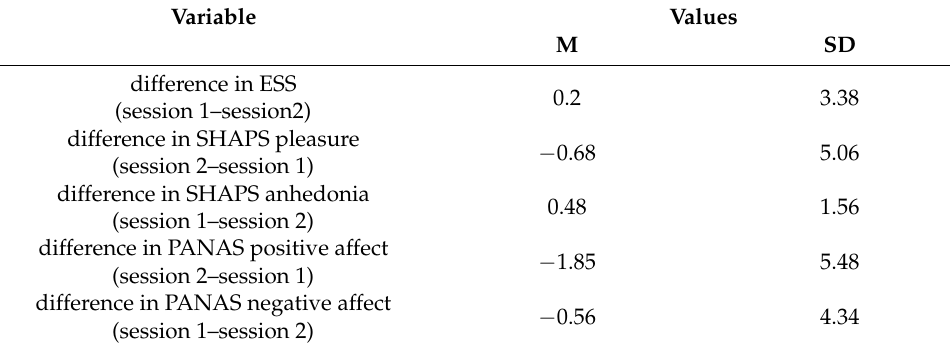
Table 1. Mean between group differences in the investigated psychological values. Positive value always indicates improvement, whereas negative values indictae